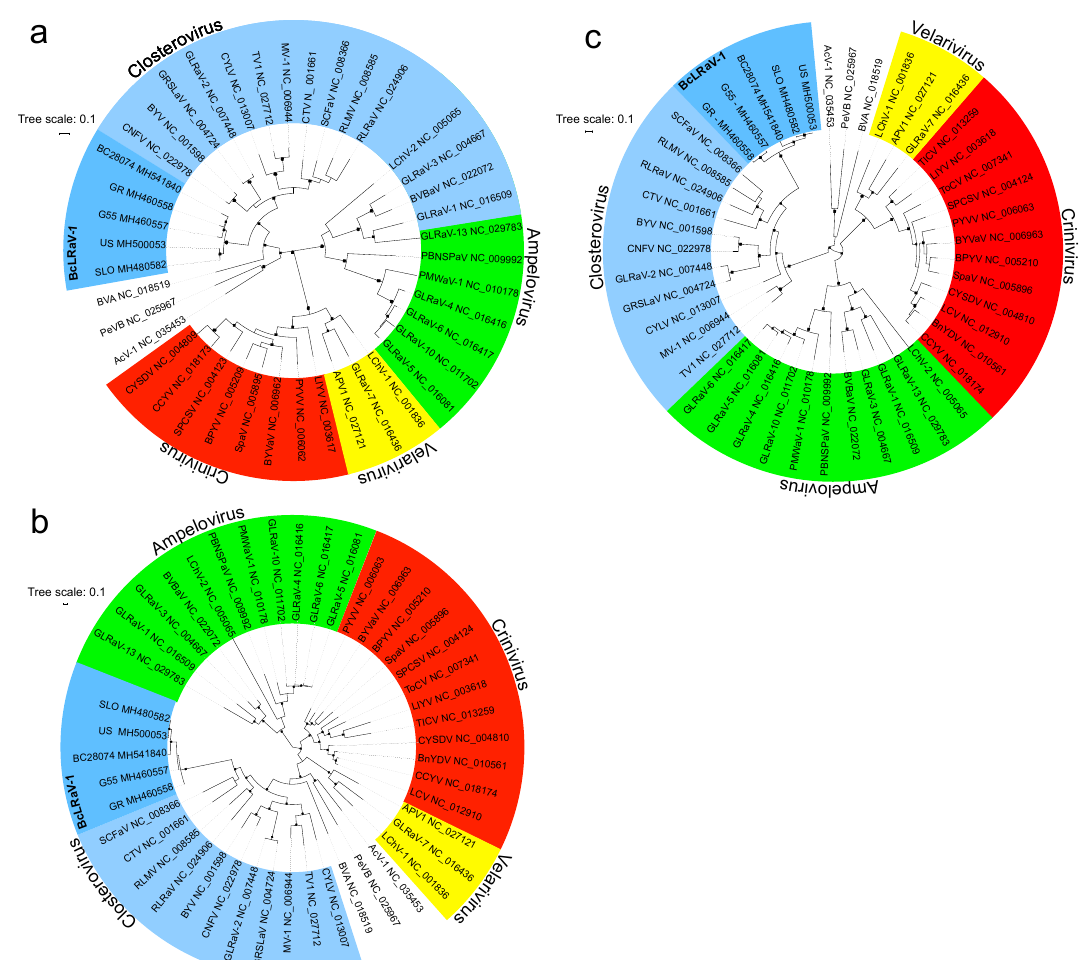
Figure 5. Phylogenetic analysis of the aligned amino acid sequences of ( a ) the polymerase (ORF2, 1b), ( b ) the coat protein (ORF6), and ( c ) HSP70h (ORF4). Branching support with values more than 80% is indicated by dots. Amino acid sequences used in the analysis were obtained from Genbank for the following members of the family Closteroviridae : actinidia virus 1 (AcV-1), areca palm velarivirus 1 (APV1), bean yellow disorder virus (BnYDV), beet pseudoyellows virus (BPYV), blackberry vein banding-associated virus (BVBaV), blackberry yellow vein-associated virus (BYVaV), blueberry virus A (BVA), carnation yellow fleck virus (CNFV), cucurbit chlorotic yellows virus (CCYV), cucurbit yellow stunting disorder virus (CYSDV), grapevine leafroll-associated virus 1 (GLRaV-1), grapevine leafroll-associated virus 3 (GLRaV-3), grapevine leafroll-associated virus 4 (GLRaV-4), grapevine leafroll-associated virus 5 (GLRaV-5), grapevine leafroll-associated virus 6 (GLRaV-6), grapevine leafroll-associated virus 7 (GLRaV-7), grapevine leafroll-associated virus 10 (GLRaV-10), grapevine leafroll-associated virus 13 (GLRaV-13), lettuce chlorosis virus (LCV), lettuce infectious yellows virus (LIYV), little cherry virus 1 (LChV-1), little cherry virus 2 (LChV-2), persimmon virus B (PeVB), pineapple mealybug wilt-associated virus 1 (PMWaV-1), plum bark necrosis stem pitting-associated virus (PBNSPaV), potato yellow vein virus (PYVV), raspberry leaf mottle virus (RLMV), strawberry pallidosis-associated virus (SpaV), sweet potato chlorotic stunt virus (SPCSV), tomato chlorosis virus (ToCV), tomato infectious chlorosis virus (TICV).